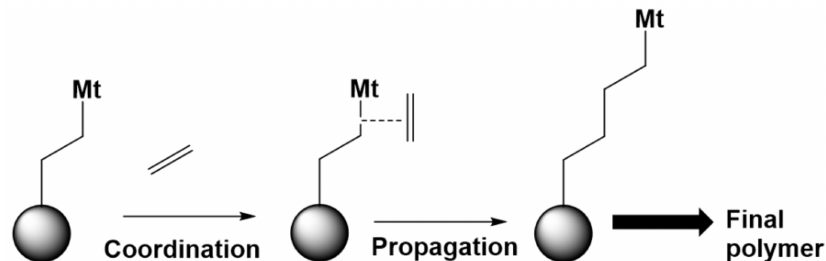
Figure 5. The main steps of catalytic olefin polymerization, as showcased with